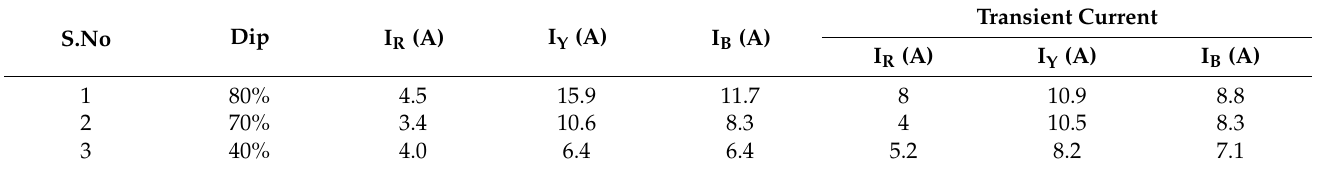
Figure 6. Voltage sag conditions in grid connected to induction motor under no load. Table 1. Induction motor under loaded conditions [neutral connected].